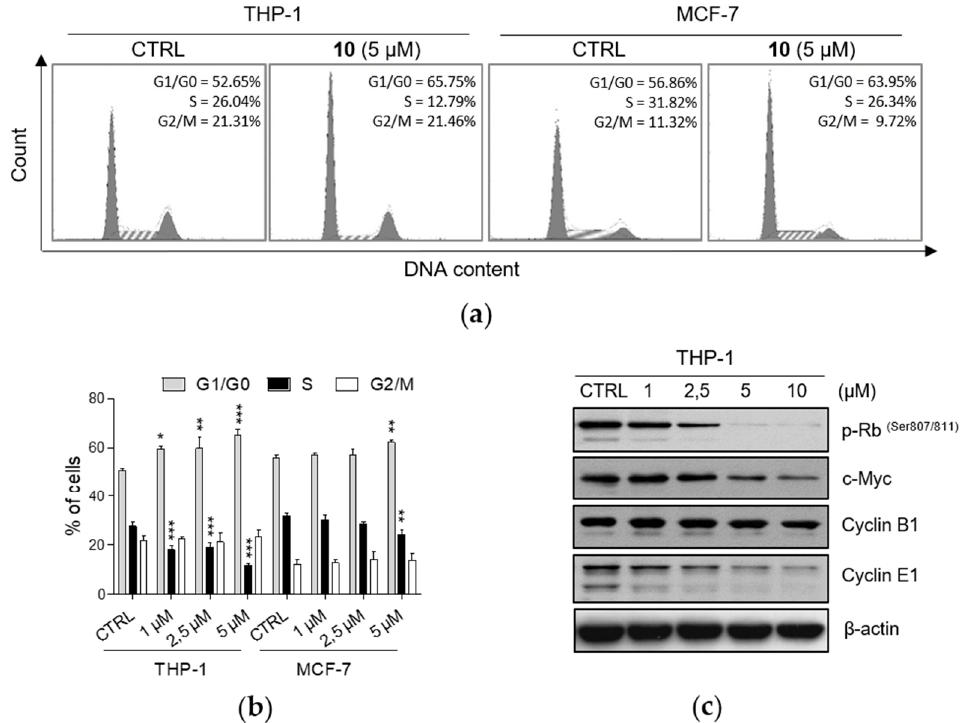
Figure 1. Compound 10 induces accumulation of THP-1 and MCF-7 cells in G1/G0 cell cycle phase. THP-1 or MCF-7 cells were treated with indicated concentrations of compound 10 for 24 h.